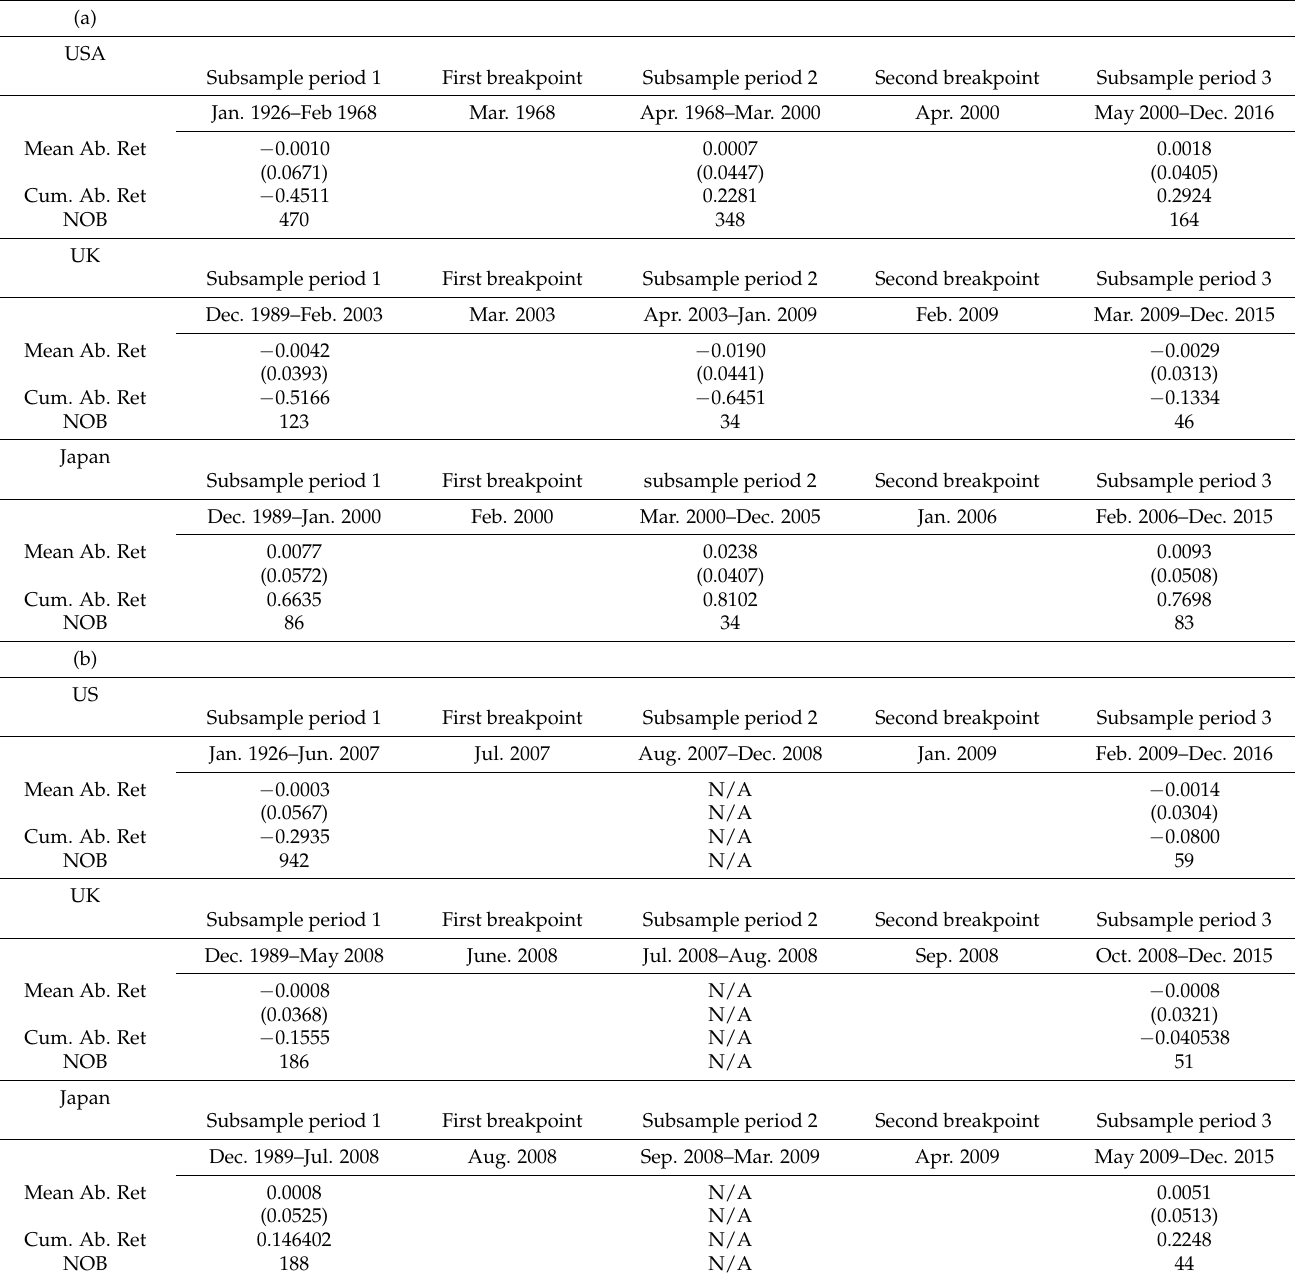
Table 11. Abnormal and cumulative abnormal returns for the USA, the UK and Japan. (a) Sample period split by breakpoints identified by the Lumsdaine–Papell test. (b) Sample period split by breakpoints identified using the Narayan and Popp